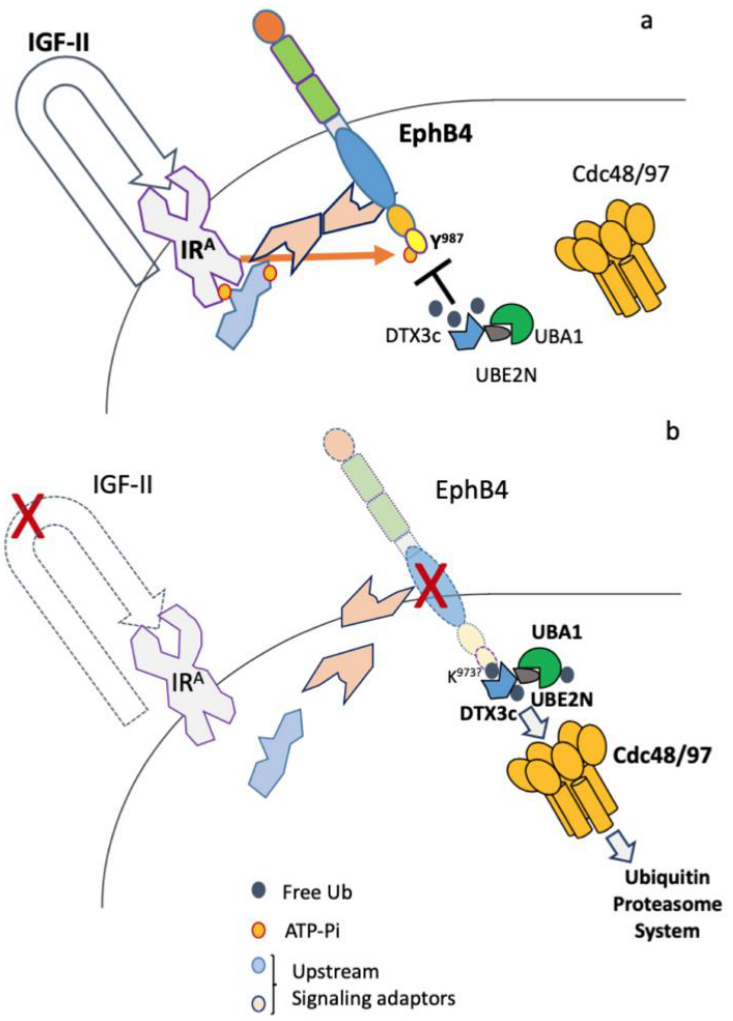
Figure 8. Proposed model for EphB4 over-expression in cancer via IGF-II/IR-A autocrine stimuli. The cumulative scenario deriving from the present work and our previously published work [26] allows us to propose a mechanistic model in which the IGF-II/IR-A autocrine signal is a key condition for EphB4 overexpression in those cells co-expressing the factors described herein. ( a ) Under such self-stimulated conditions (such as those in cancers secreting IGF-II), the IR-A tyrosine kinase can phosphorylate EphB4 on its c-terminal Tyr987 residue. Such phosphorylation has an inhibitory role on EphB4 C-terminal degron recruitment by DTX3c (E3-ligase), causing an extended expression half-life of EphB4 and its cancer-promoting functions. ( b ) Upon IGF-II signal neutralization, EphB4 Tyr987 is rapidly dephosphorylated and its C-tail is ubiquitinylated, allowing DTX3c and its associated degradation partners to exert their UPS-mediated role.